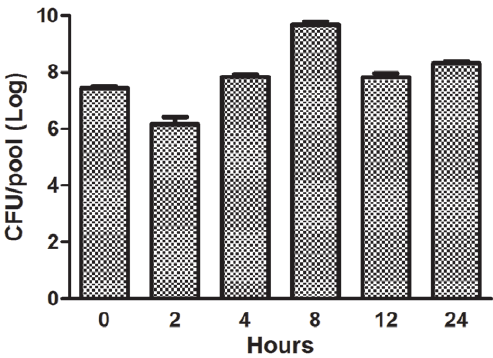
Figure 2. Number of bacterial cells in G.mellonella hemolymph post E.faecium E007 infection. The caterpillars were infected with 5.3 6 10 7 CFU/larva and were maintained at 37 u C. Number of bacterial cells was quantified from pools of five larvae hemolymph per time- point (0, 2, 4, 8, 12 and 24 h after infection). Bars represent mean and the standard deviation of three pools per time-point.